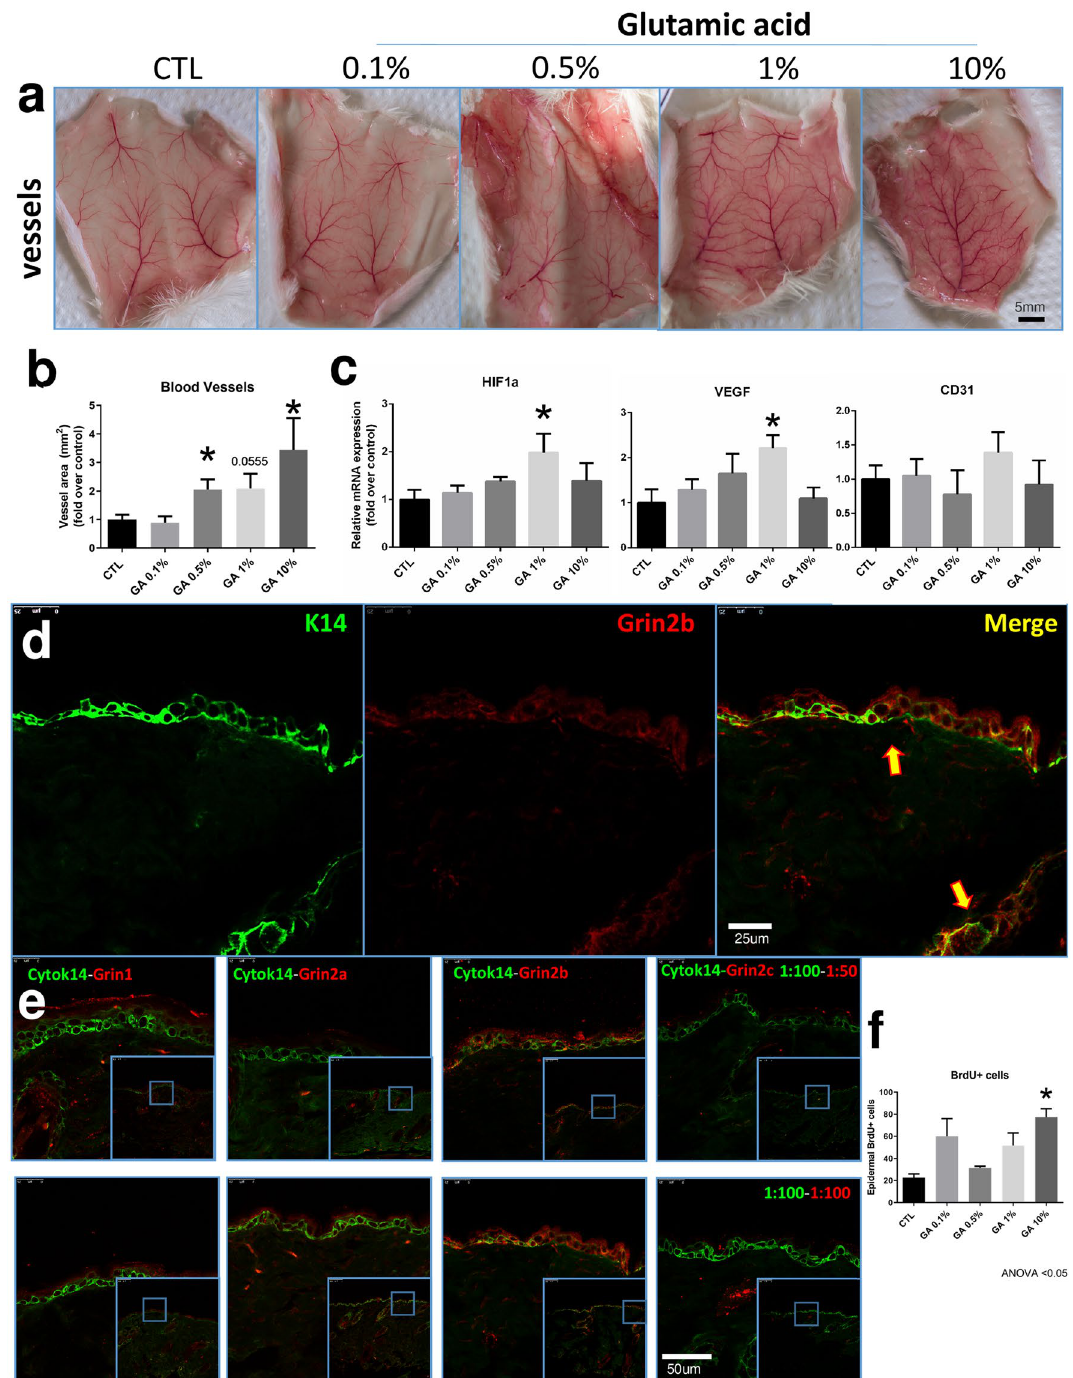
Figure 4. Topical GA and blood vessel. Skin samples treated for 14 days with topical GA topical. Upside- down back skin samples showing vessel differences between Vaseline (CTL) or 0.1%, 0.5%, 1% and 10% GA treatments ( a ). Quantification of blood vessel area after 14 days of vaseline (CTL) or 0.1%, 0.5%, 1% and 10% GA treatment ( b ). Gene expression of Hypoxia Inducible Factor 1 Subunit Alpha (Hif1a), Vascular Endothelial Growth Factor A (Vegf) and the Platelet and Endothelial Cell Adhesion Molecule 1 (Cd31) from full-thickness back skin after 14 days of GA treatment ( c ). GA receptor characterization in mice skin of different GA subunits (d-e). Immunostaining against NMDA Grin1, Grin2b, Grin2a and Grin2c GA receptor expressed in the epidermal layer of the skin of untreated mice ( d – e ). Yellow arrows indicate colocalization of K14 + Grin2b + cells ( d ). Quantification of positive BrdU epidermal and hair follicle cells of mice skin treated with vaseline (CTL) or 0.1%, 0.5%, 1% and 10% of GA (f). BrdU and quantitative PCR data are presented as mean ± SEM * < p 0.05 ANOVA. 5–6 animals per